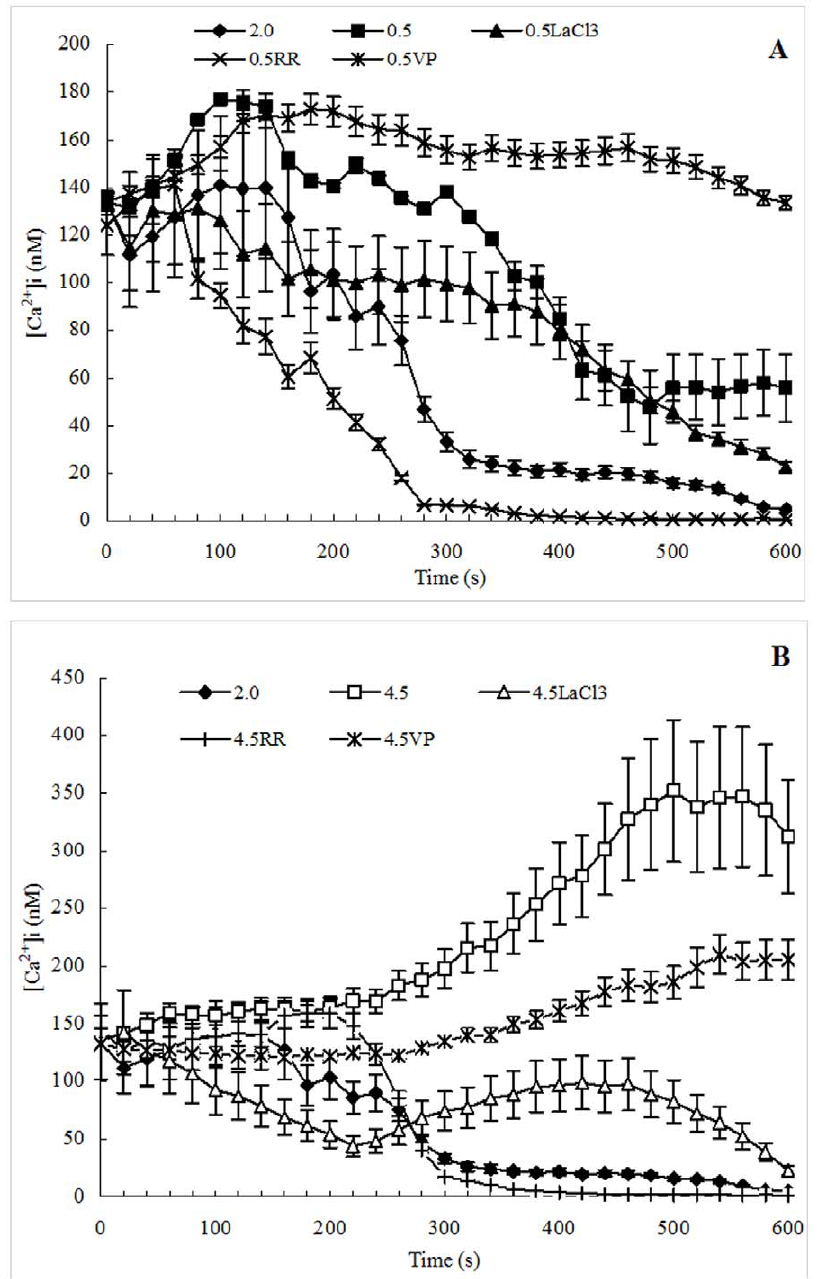
Figure 1. Effect of Ca 2 + channel blockers on Ca 2 + concentration in D. salina under hypoosmotic or hyperosmotic stress. A: Hypoosmotic stress; B: Hyperosmotic stress. Data points represent the means of three replicated studies in each sample, with the SD of the means (T test, p , 0.05).